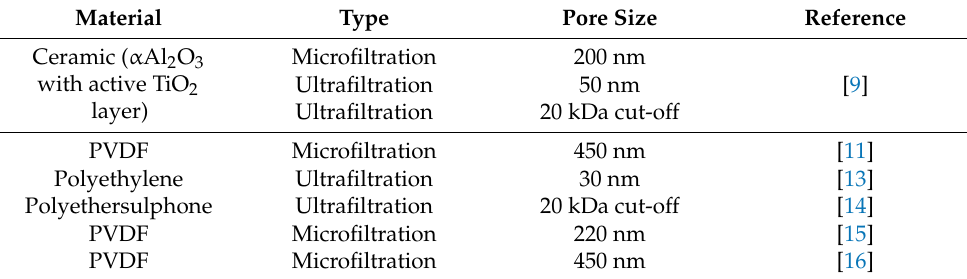
Table 1. Features of membranes applied in the treatment of anaerobic digester/bioreactor